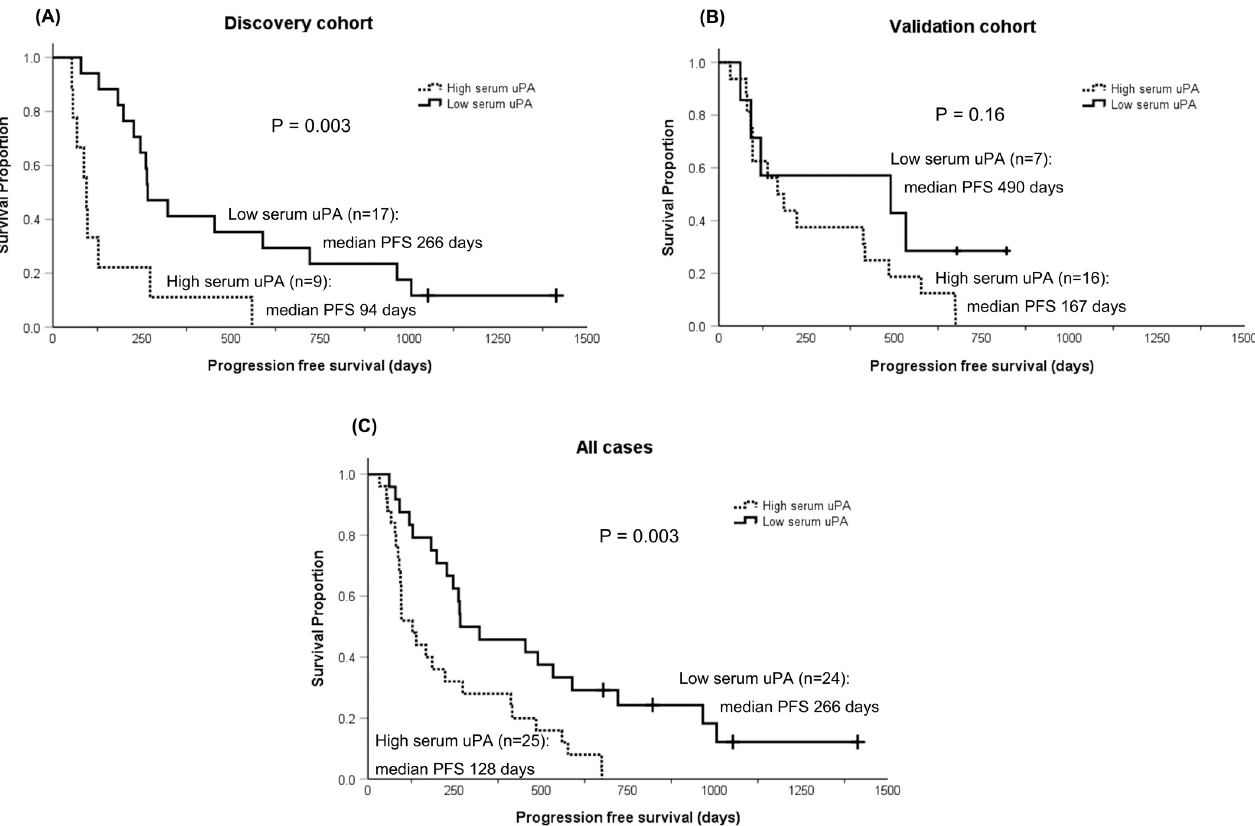
Fig 2. Kaplan-Meier curves for dogs with low or high serum uPA. Kaplan-Meier curves for progression free survival (PFS) of dogs with osteosarcoma treated with a limb amputation and carboplatin chemotherapy. (A) Kaplan-Meier curves for the 26 dogs in the discovery cohort. Median PFS was 266 days for dogs with low serum uPA (n = 17, solid line) versus 105 days for dogs with high serum uPA (n = 9, dashed line; p = 0.003). (B) Kaplan-Meier curves for the 23 dogs in the validation cohort. Median PFS was 490 days for dogs with low serum uPA (n = 7, solid line) versus 167 days for dogs with high serum uPA (n = 16; dashed line; p = 0.16). (C) Kaplan-Meier curves for all 49 dogs combining the discovery and validation cohorts. Median PFS was 266 days for dogs with low serum uPA (n = 24, solid line) versus 128 days for dogs with high serum uPA (n = 25, dashed line; p = 0.003).